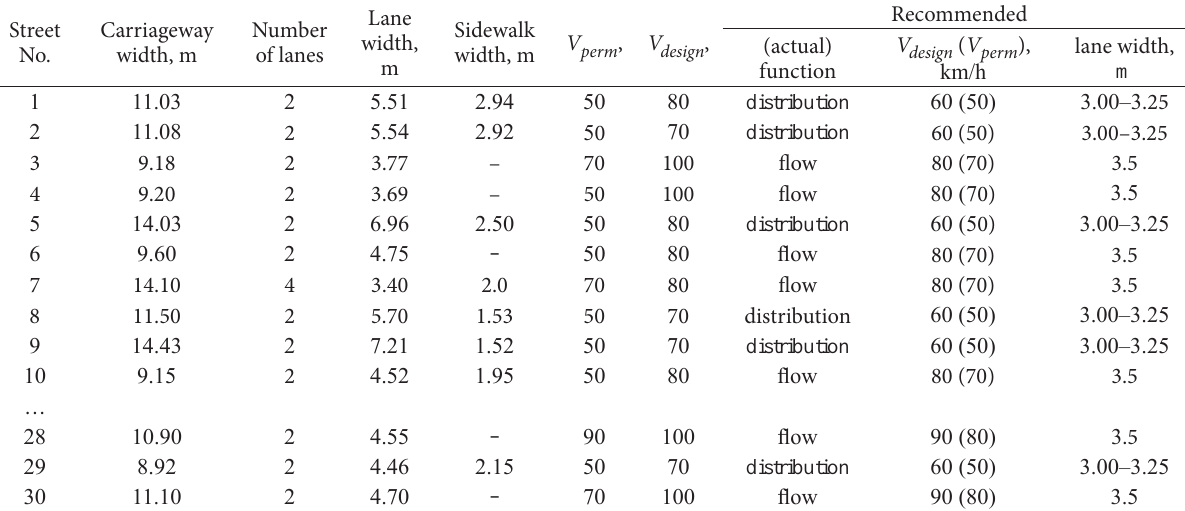
Table 4. Geometrical parametres of streets in urban street network Street